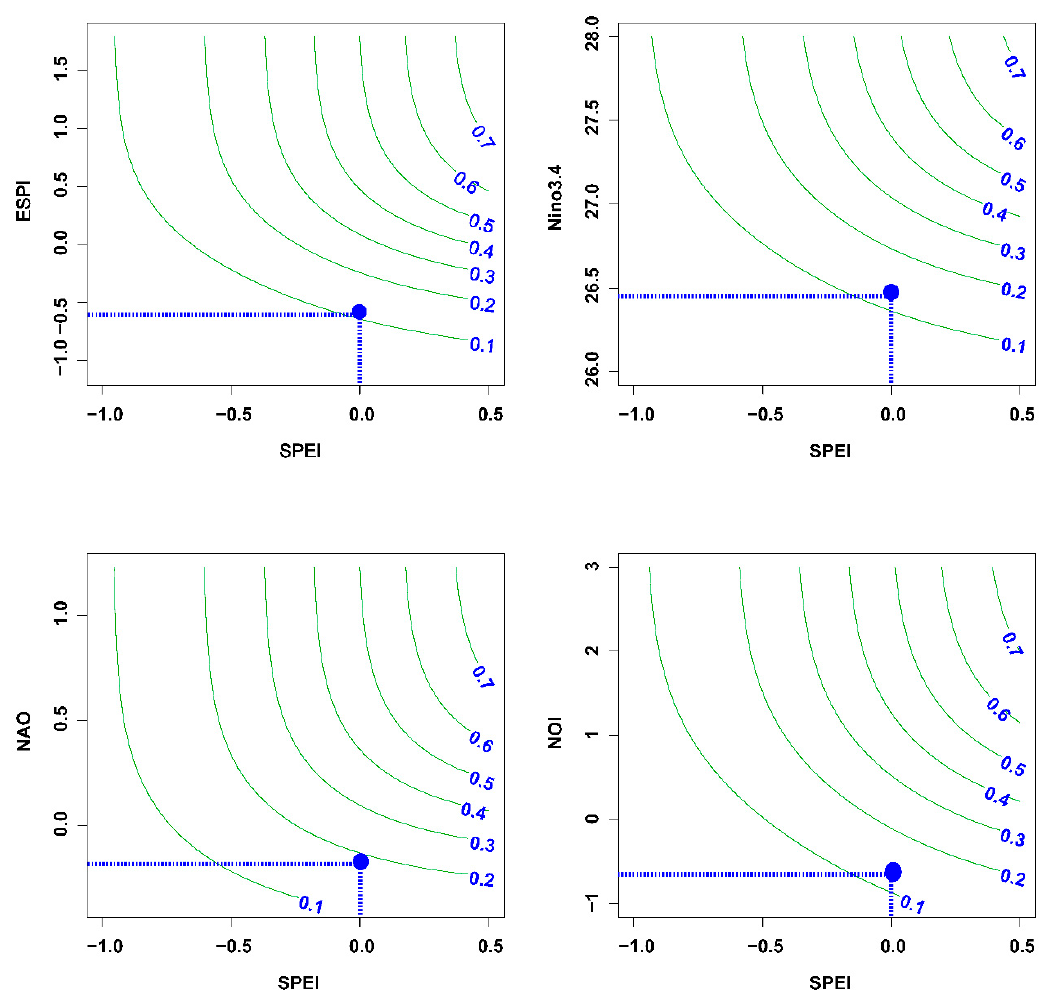
Figure 7. The joint probability distribution of SPEI and the GCV (when SPEI < 0). The intersection point indicates the probability of being less than the coordinate value at the same time.